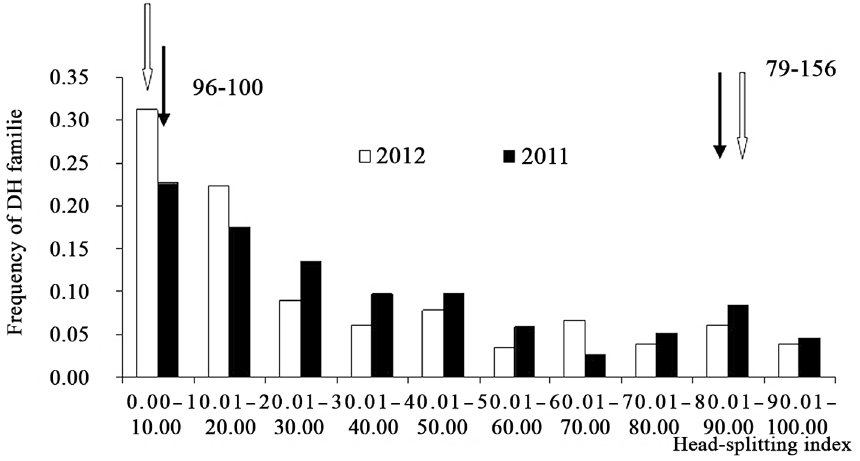
Fig 3. Frequency distribution of head-splitting index in DH families in 2011 and 2012. Arrows indicate the mean head-splitting index of the parental lines.